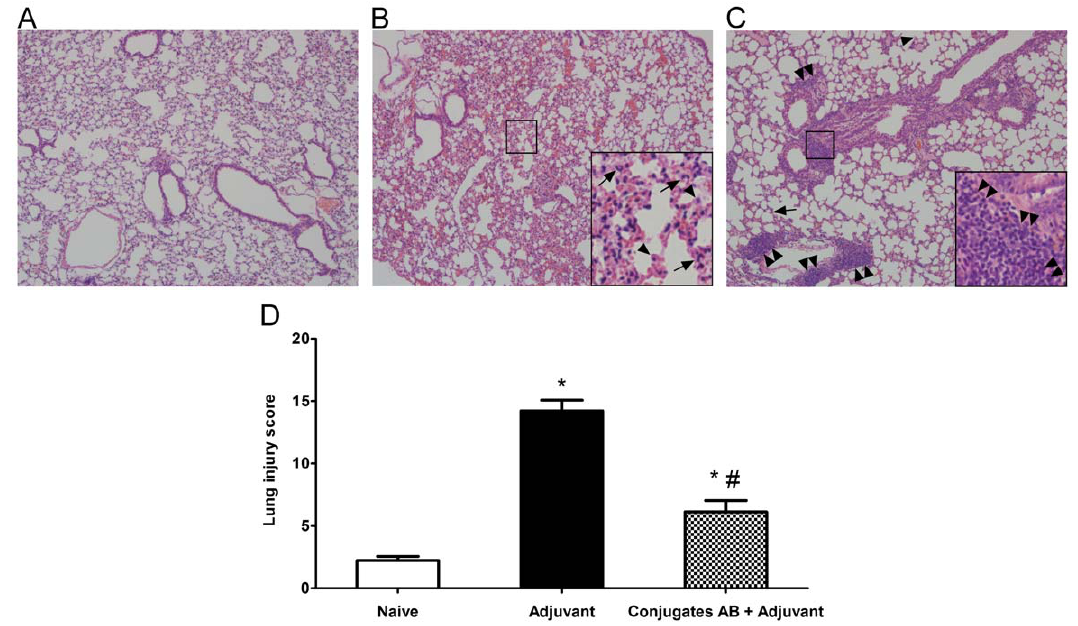
Figure 4. Histopathology of mouse lungs after challenge with M.catarrhalis . Mice were vaccinated intranasally (1 dose per week, 4 doses in total) with either the adjuvant cholera toxin alone (1 m g/dose/mouse) or the combined conjugates AB (2.5 m g of each carbohydrate per dose per mouse) plus adjuvant. One week after the last booster, mice were challenged with aerosolized M. catarrhalis . Mouse lungs were harvested 6 h later for H&E staining. (A) Normal lung of a naive mouse; (B) Lung of the mouse administered with adjuvant only; (C) Lung of the mouse vaccinated with the combined conjugates AB plus adjuvant. Arrows and arrowheads show infiltrating neutrophils and macrophages, respectively, in inflamed lungs of mice after challenge by M. catarrhalis strains. Double arrowheads show proliferating lymphocytes in the lungs of conjugate-immunized mice after challenge by M. catarrhalis strains. Original magnification 6 100; 6 400 ( insets ). (D) Histopathological lung injury scores for mice receiving either the adjuvant only or the combined conjugates AB plus adjuvant followed with M. catarrhalis challenges. The scores were obtained from 10 random fields per mouse and 6 mice per group at magnification 6 400. The categories used to generate the score were intra-alveolar infiltrates, alveolar septal thickeness, alveolar hemorrhage, and intra-alveolar proteinaceous exudates. Data are expressed as mean 6 SD. * P , 0.05 or # P , 0.05 indicates the significant difference vs naive mice or adjuvant only administered mice by ANOVA, respectively.